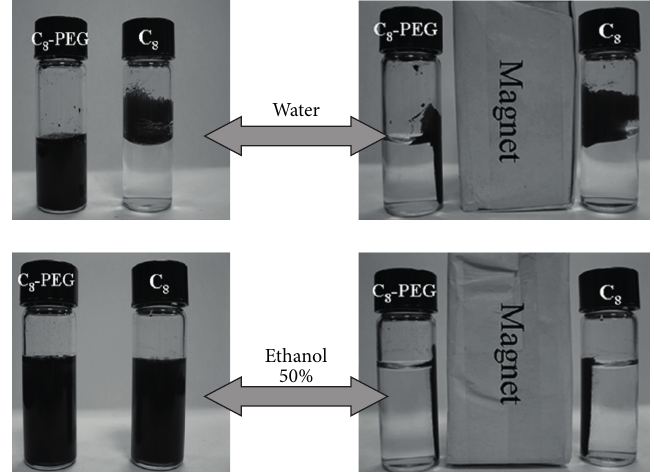
Figure 5: Comparison of C 8 and C 8 -PEG dispersed in